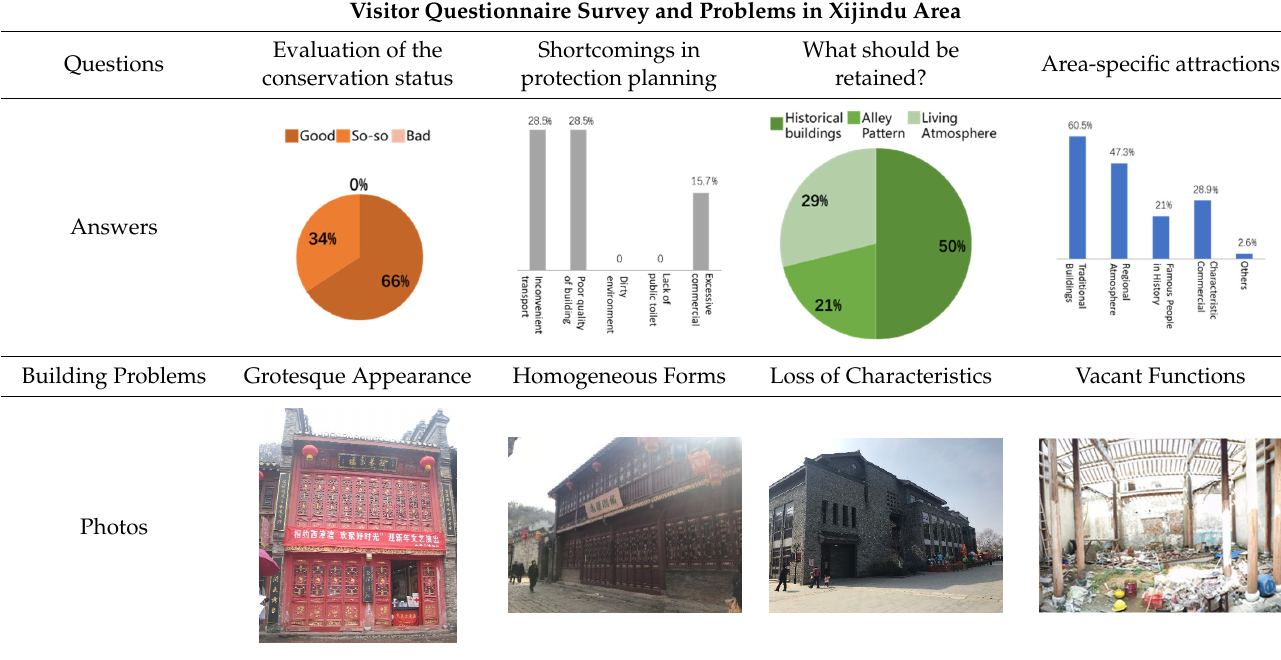
Table 1. Visitor questionnaire survey and problems in Xijindu area.